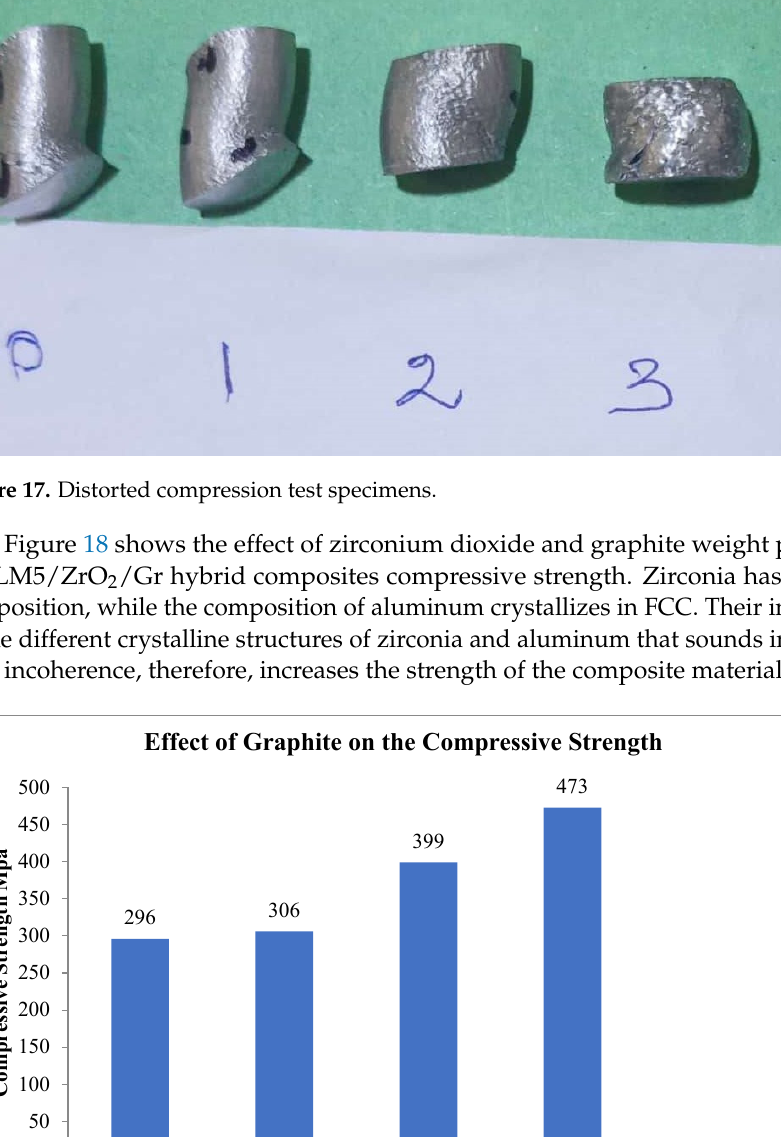
Figure 16. S ample stress-strain curves of compression test specimens.